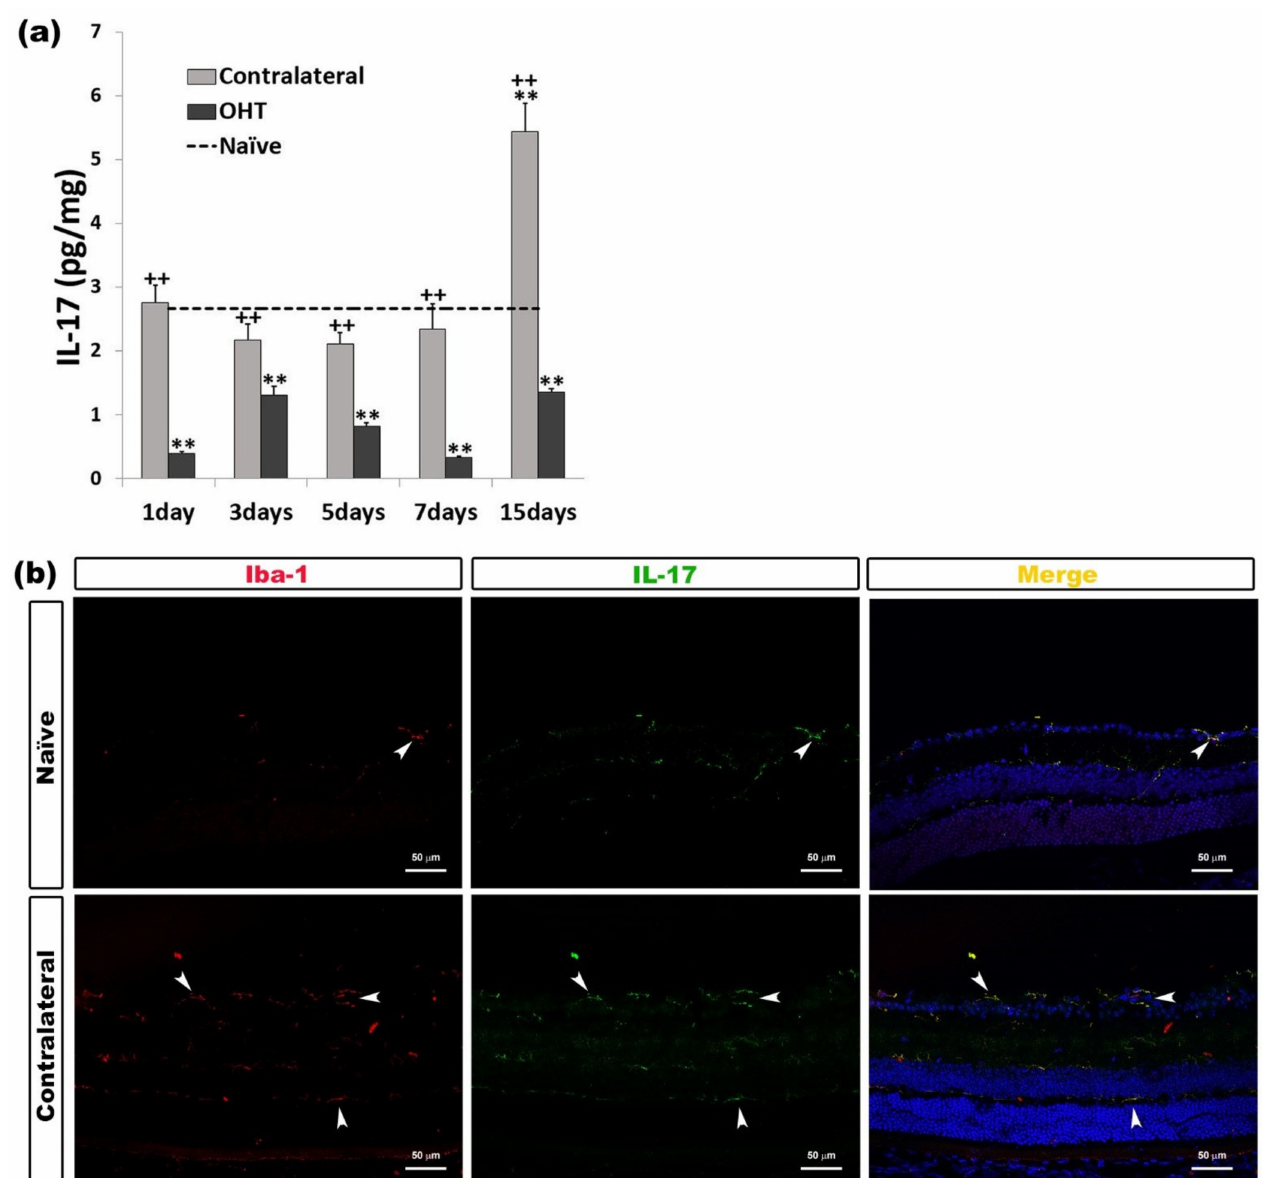
Figure 5. IL-17 levels at different times after laser-induced ocular hypertension (OHT). ( a ) The variation over time in the IL- 17 levels in the multiplex assay. The histogram shows the mean levels ( ± SD) of IL-17 (pg/mg) at days 1, 3, 5, 7, and 15 after laser OHT induction, in ocular hypertension eyes (OHT) and in contralateral eyes. The dashed line indicates the mean levels in naïve eyes. Statistical significance indicators: ** p < 0.01 vs. naïve; ++ p < 0.01 vs. OHT. ( b ) Immunohistochemical study of IL-17 expression in contralateral eyes 15 days after unilateral laser-induced OHT. Retinal sections were immunolabeled with antibodies to IL-17 (green) and Iba-1 (red). Merge (yellow). The arrowheads show the co-expression of Iba-1 and IL-17 in naïve and contralateral eyes; it is more intense in contralateral eyes. Abbreviations: OHT (ocular hypertension); IL-17 (interleukin 17); Iba-1 (ionized calcium-binding adaptor molecule